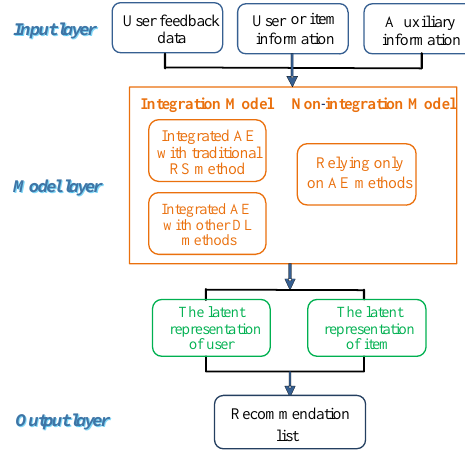
Figure 7. The architecture of AE-based RSs.